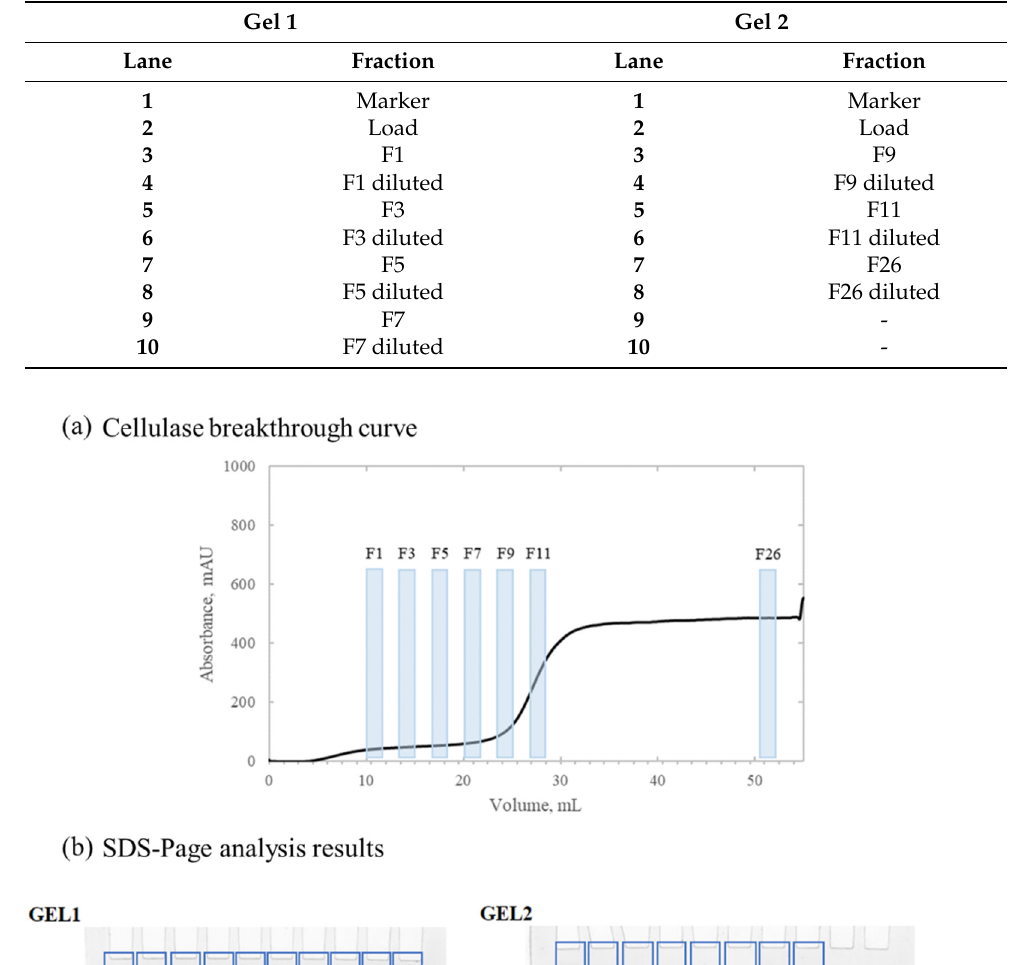
Table 2. Scheme of the lanes of the SDS-Page in Figure 3b.